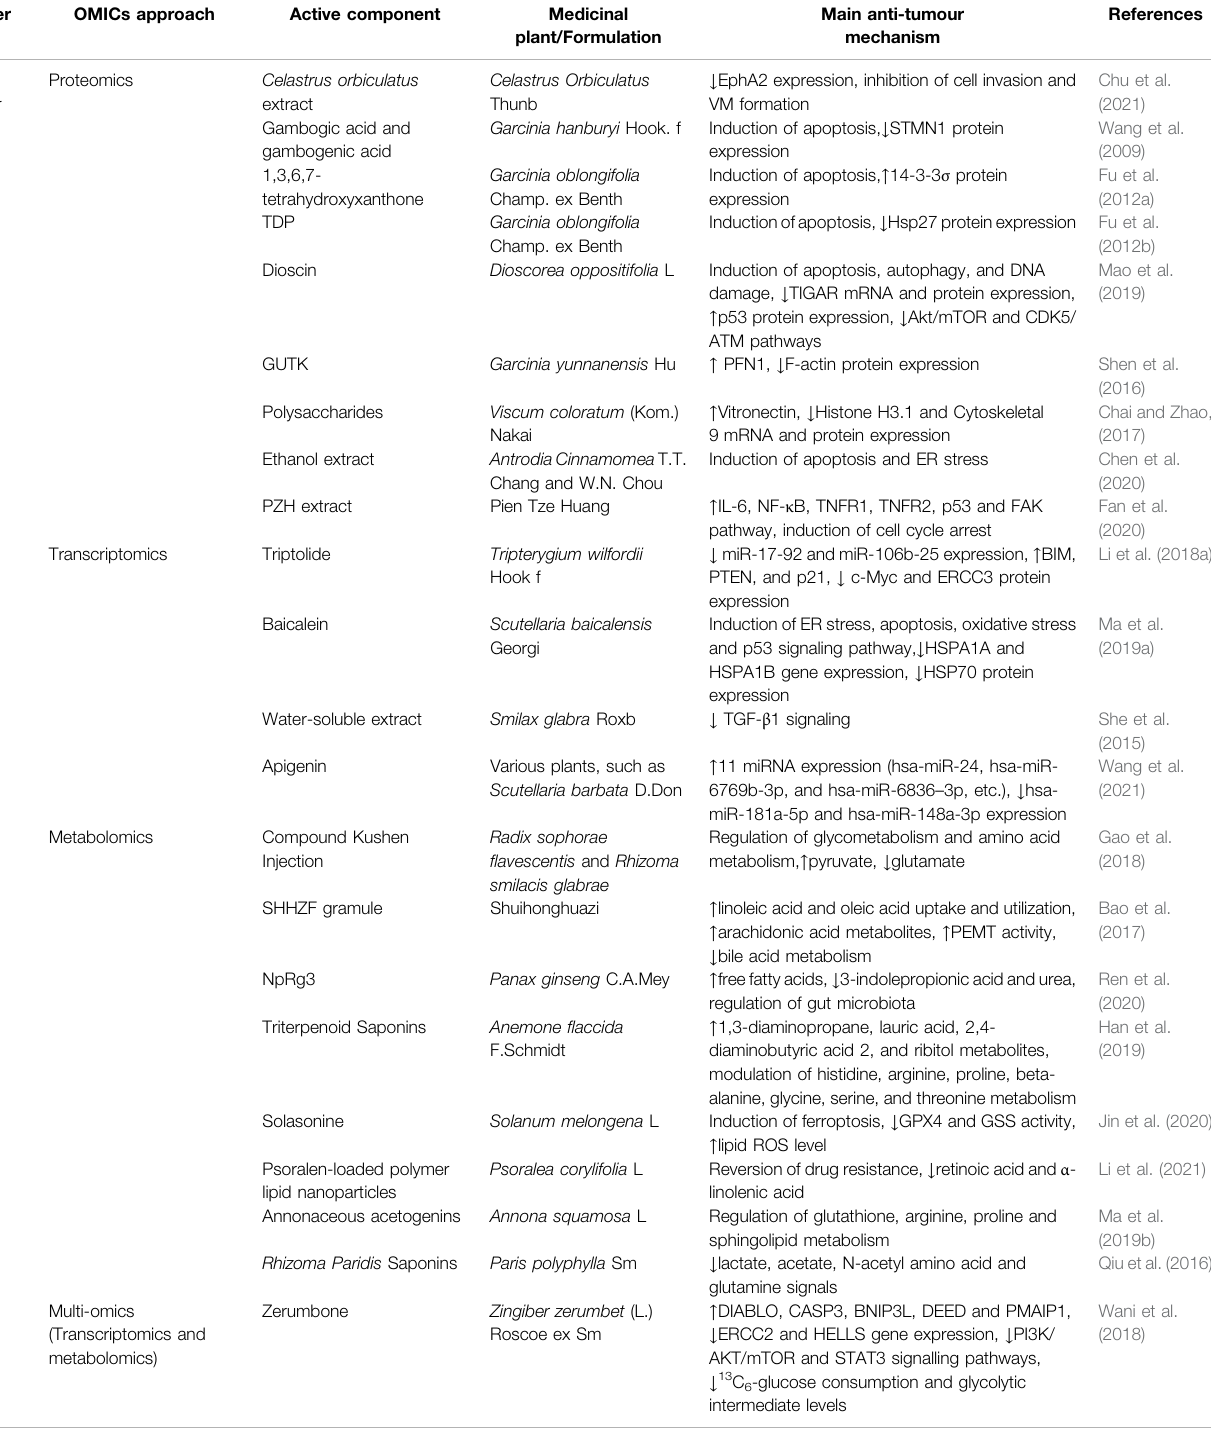
TABLE 3 | The applications of OMICS on medicinal plants in liver